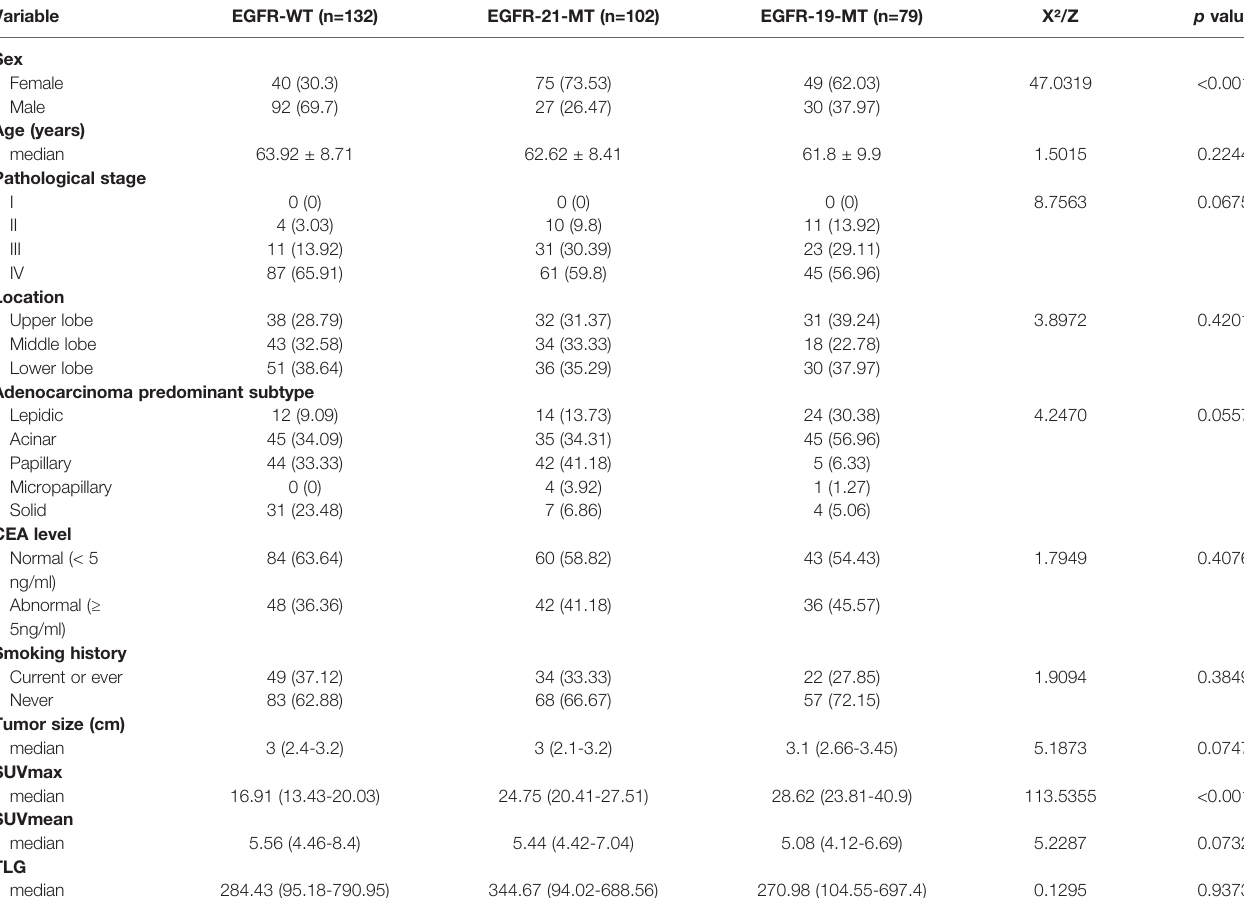
TABLE 1 | Demographic information and clinicopathological characteristics of selected patients with